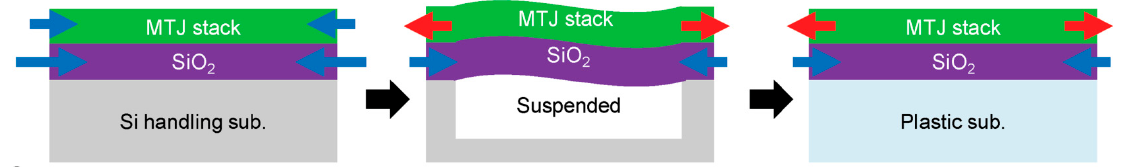
Figure 10. Schematic diagrams of transferring the MTJ stack. Adapted with permission from Ref. [91].